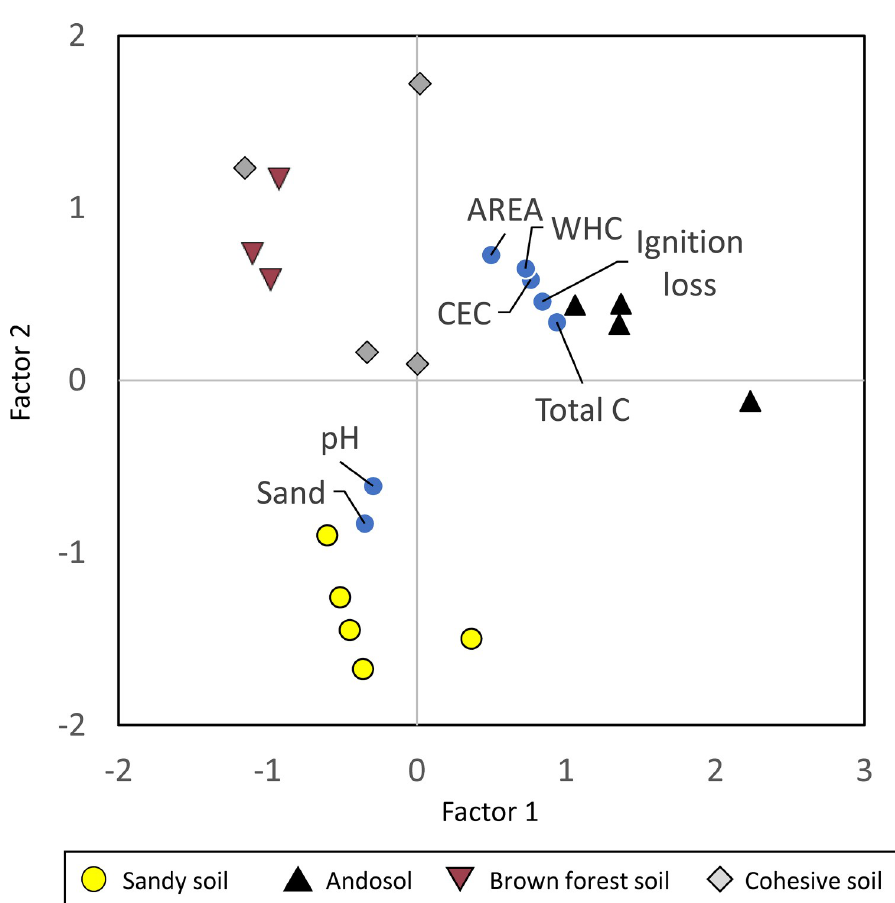
Fig 3. Plot of factor analysis scores for soil properties and 17 soil